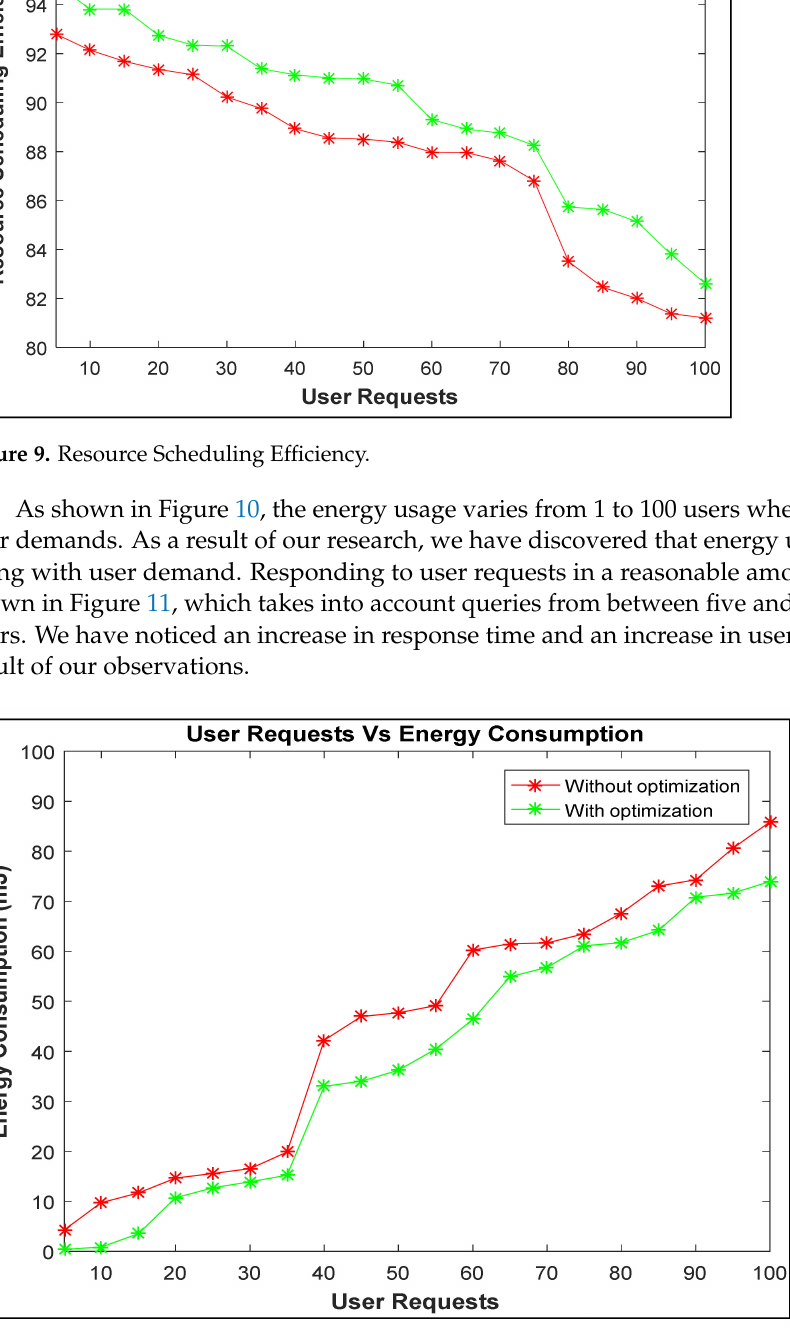
Figure 10. Energy